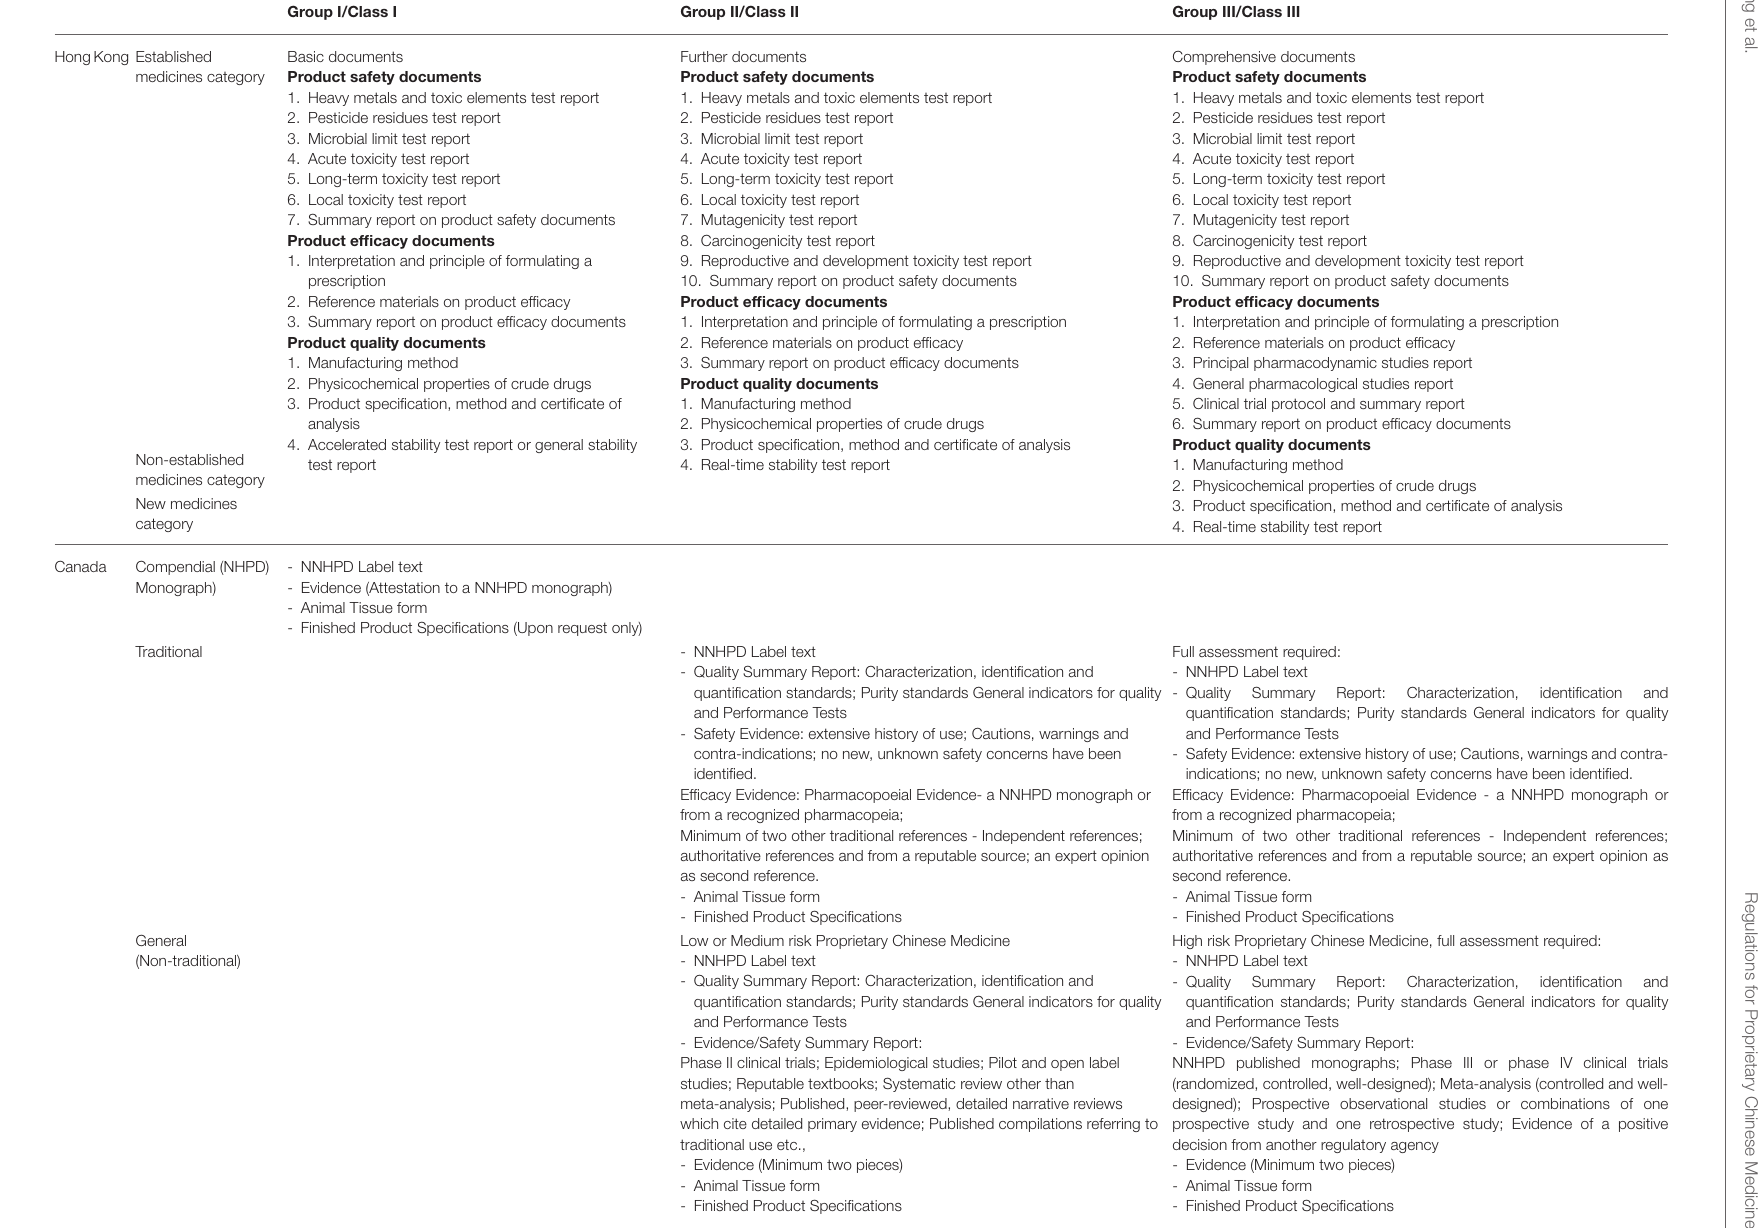
TABLE 1 | Product license application requirements summary for Hong Kong and Canada (5,